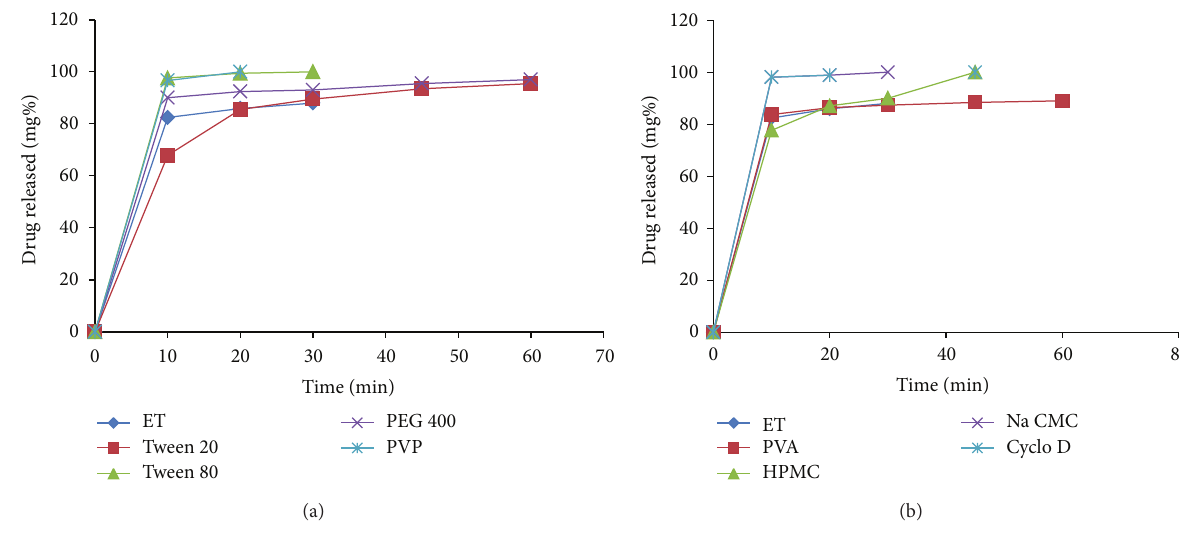
Figure 4: (a) Dissolution profiles of ET nanosuspensions prepared by pH shift method in phosphate buffer pH 6.8. 𝑃 = 0.96 not significant one-way ANOVA but 𝑃 = 0.01 significant two-way ANOVA. (b) Dissolution profiles of ET nanosuspensions prepared by pH shift method in phosphate buffer pH 6.8. 𝑃 = 0.97 not significant one-way ANOVA, 𝑃 = 0.0011 significant two-way ANOVA.